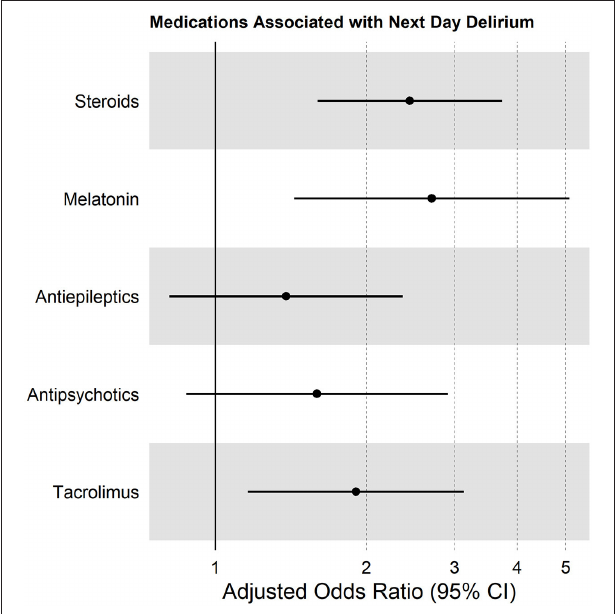
FIGURE 4 | Forest plot showing multivariable analysis of medications associated with next-day delirium, accounting for within-site correlation, and controlled for patient age and need for supplemental